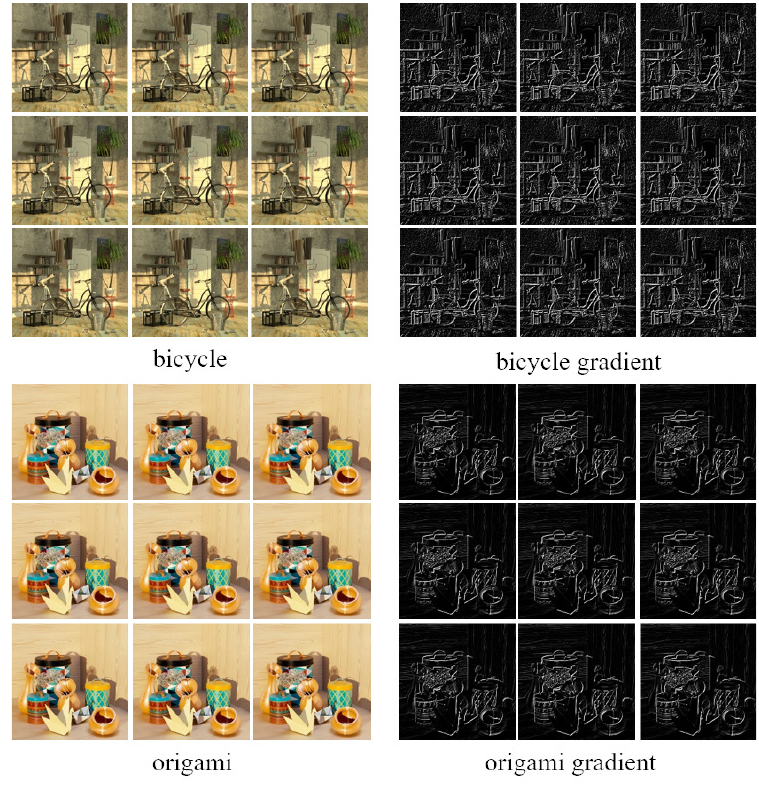
Figure 3. Original and Bicycle scene image ( left ) and their gradient image using Sobel Operator [14].